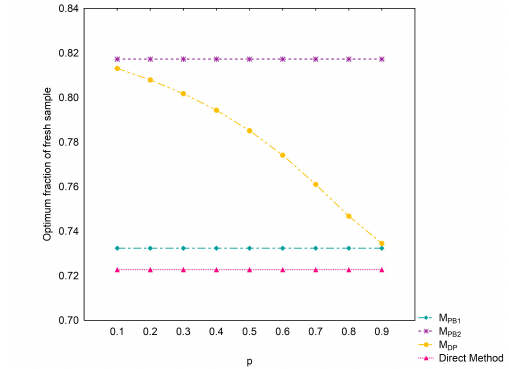
Figure 2 – Optimum value of fraction of sample drawn afresh for proposed improved class of estimator under three scrambled response models and under direct